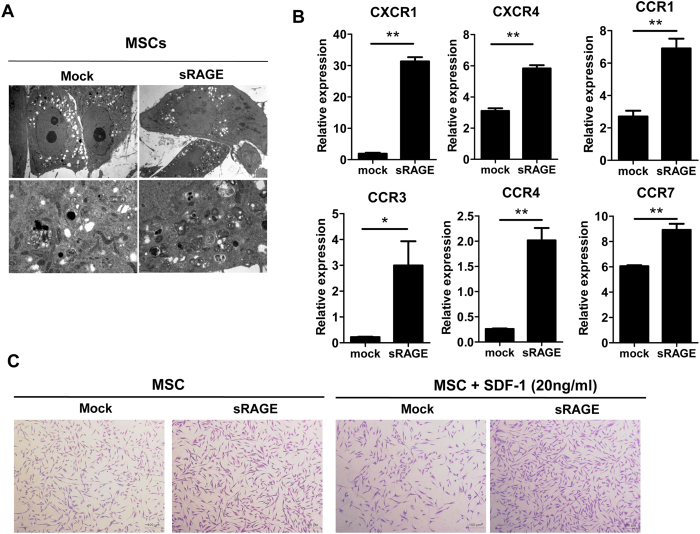
Cellular activity and migration of mesenchymal stem cells (MSCs) overexpressing soluble receptor for advanced glycation end products(sRAGE).(A) MSCs were transfected with the mock or sRAGE vector using the X-tremeGENE HP reagent for 3 days. Representative electron micrographs show the ultrastructure of mock- or sRAGE-transfected MSCs. (B) Transcript levels of chemokine (C–X–C motif) receptor 1 (CXCR1), CXCR4, chemokine (C–C motif) receptor 1 (CCR1), CCR3, CCR4, and CCR7 were determined by real-time PCR. Data represent the mean ± s.d. (bars) values from three independent experiments. *P < 0.05. (C) Representative images of transmigrated MSCs (left) and sRAGE-MSCs (right) in response to stromal-derived factor-1 (SDF-1). MSCs were seeded in the upper chamber, and SDF-1 (30 ng/mL) was added to the bottom chamber of a 24-well Transwell unit (pore size, 8.0 μm).After 10 h, the migrated cells were stained with crystal violet. Scale bar = 100 μm.